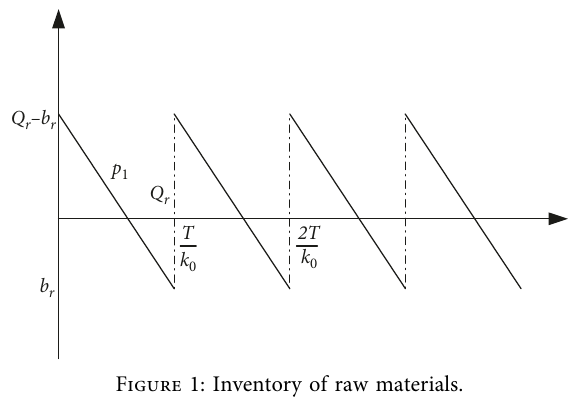
Figure 1: Inventory of raw materials.